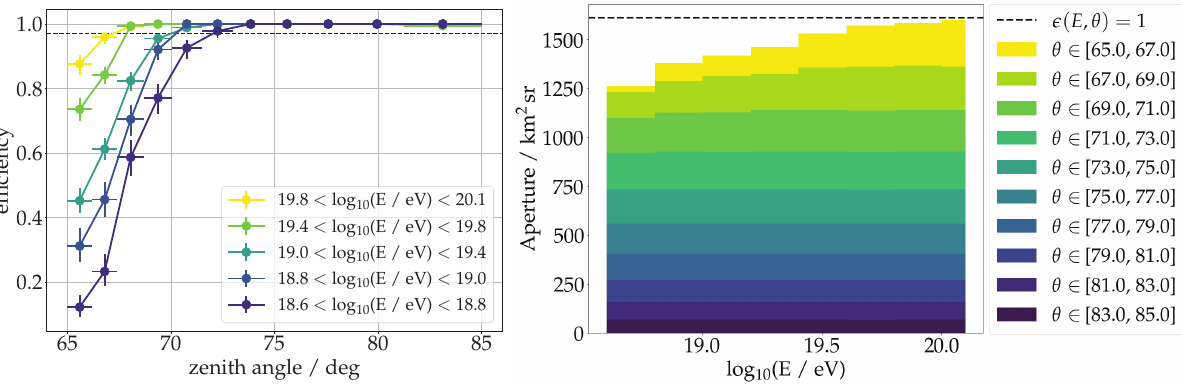
Figure 4. Left: Detection e ffi ciency with the Auger Radio Detector as a function of zenith angle an particle energy. The dashed line marks an e ffi ciency of 97%. The error bars denote statistical uncertainties. Right: Stacked histogram of the aperture of the Auger Radio Detector as a function of zenith angle and energy. This applies to contained showers which have their impact point in the geometrical 3,000km 2 area of the Pierre Auger Observatory.